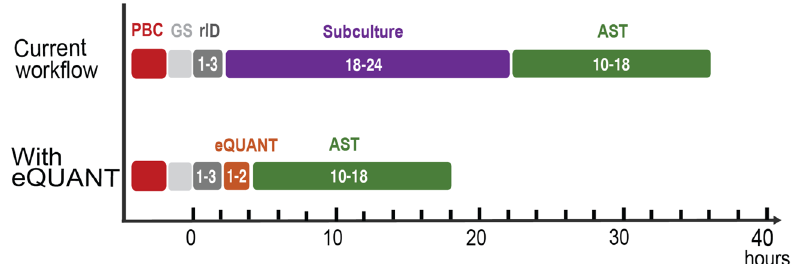
Figure 1. Accelerated AST workflow with eQUANT. The current laboratory workflow starts with a positive blood culture (PBC, red box) followed by a Gram stain (GS, light grey box) and rapid organism identification if available (rID, dark grey box). Bacteria from the PBC are subcultured and a 0.5 McF is prepared from colonies. The 0.5 McF is then used to lawn an agar plate for disk diffusion or utilized in an automated AST platform.